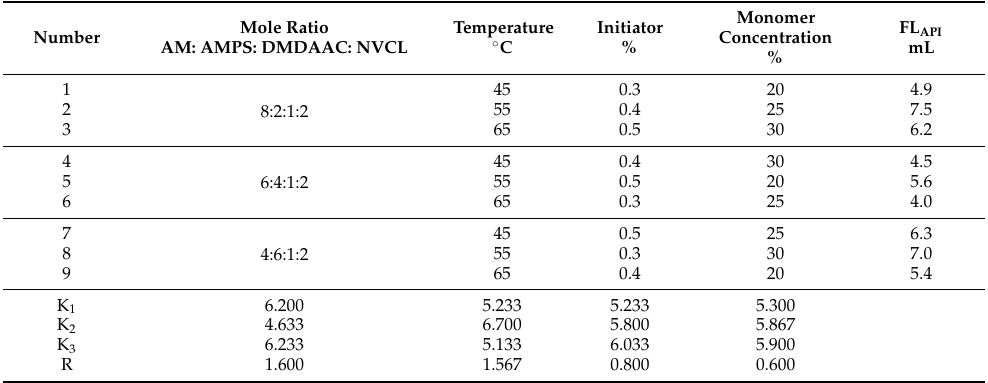
Table 1. Orthogonal experimental design and results of polymer AADN synthesis conditions.